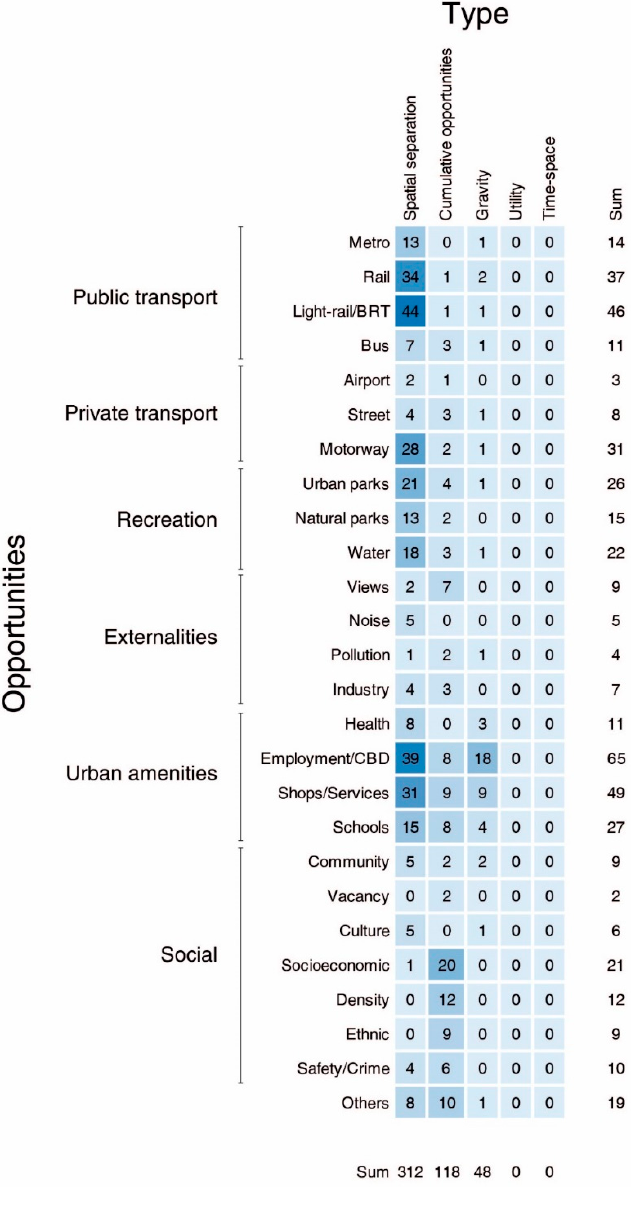
Figure 3. The frequency of the use of the specific combination of opportunities and types of accessibility measures in the reviewed sample of papers. The numbers in the figure represent the amount of times the combination opportunity-type is used; the darker blue, the more frequent this combination is used; the sum shows the total amount of times that the opportunity or type is used, irrespective of the other aspect.